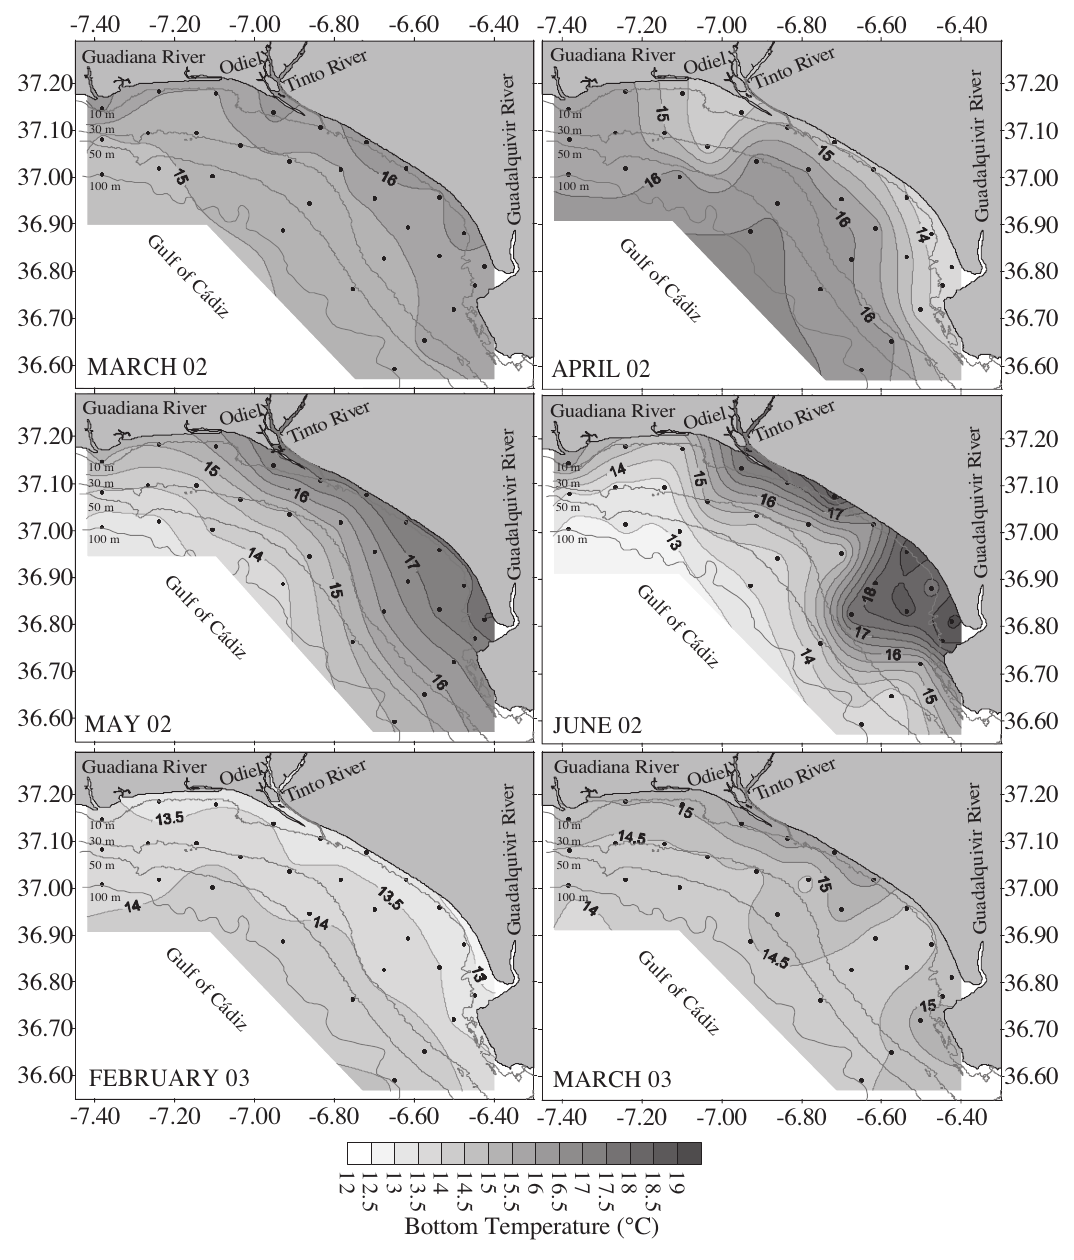
F IG . 8. – Distribution of bottom temperature (ºC) during the wedge sole main reproduction